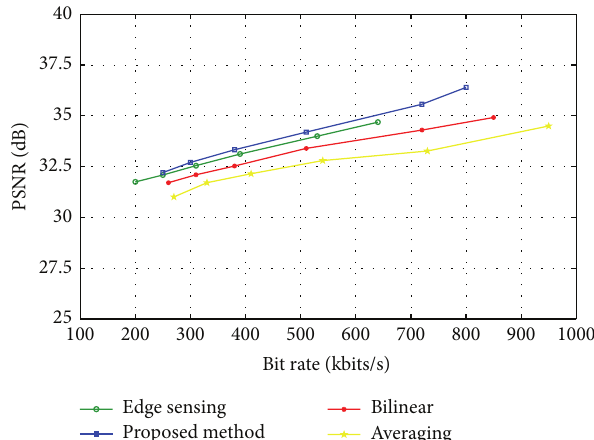
Figure 8: PSNR values at different bit-rates using interpolation and theproposedmethod(Stefansequence)whenonedescriptionislost.